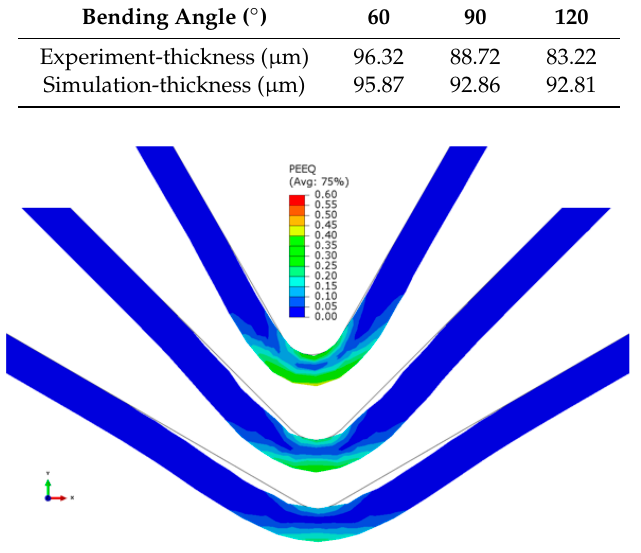
Table 2. The thickness of round corner after springback for Ni/Cu annealed under 850 °C. Bending Angle (°)